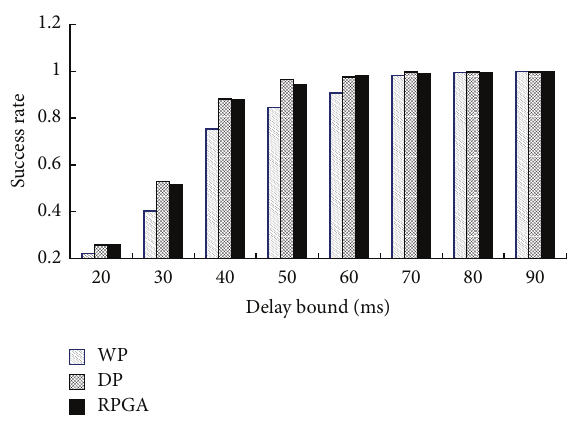
Figure 11: Comparison with three methods on the success rates for different delay